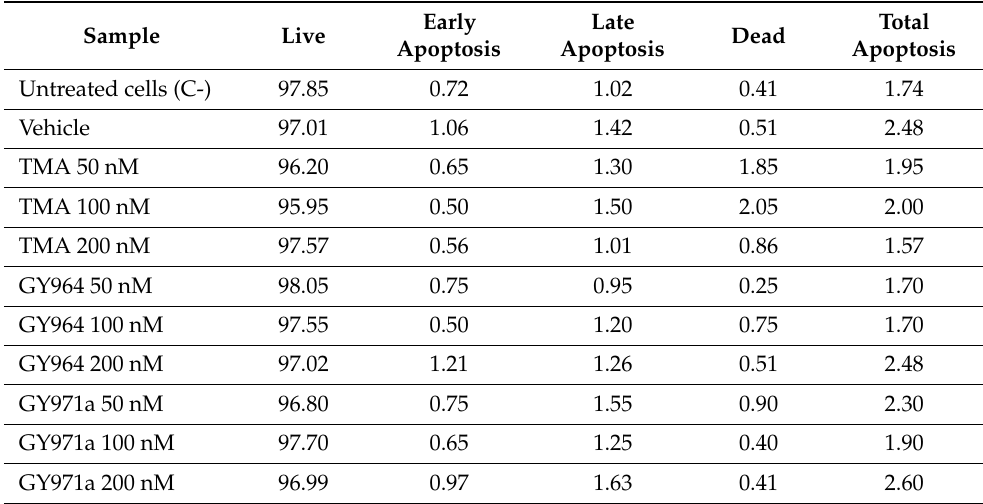
Table 2. Pro-apoptotic activity (%) of TMA and GY964 (4-PhDMA), dissolved in DMSO (Vehicle), and GY971a (pANDMA), dissolved in water, on IB3-1 cells. Sample Live